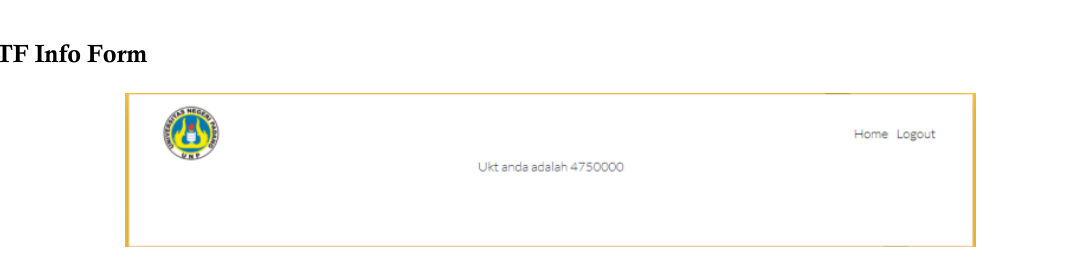
Figure 12. STF Info